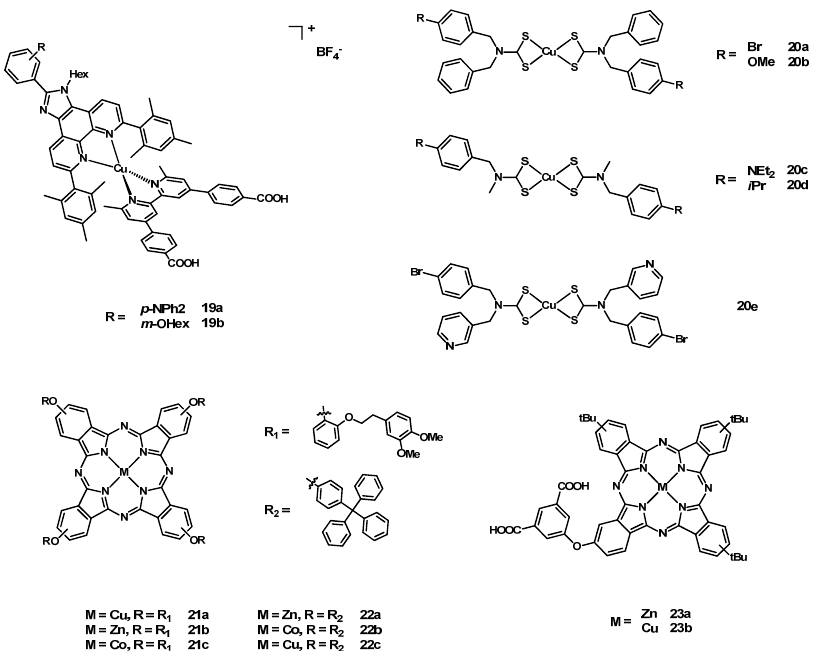
Figure 10. Structure of dyes 19a – b , 20a – e , 21a – c , 22a – c, and 23a – b .